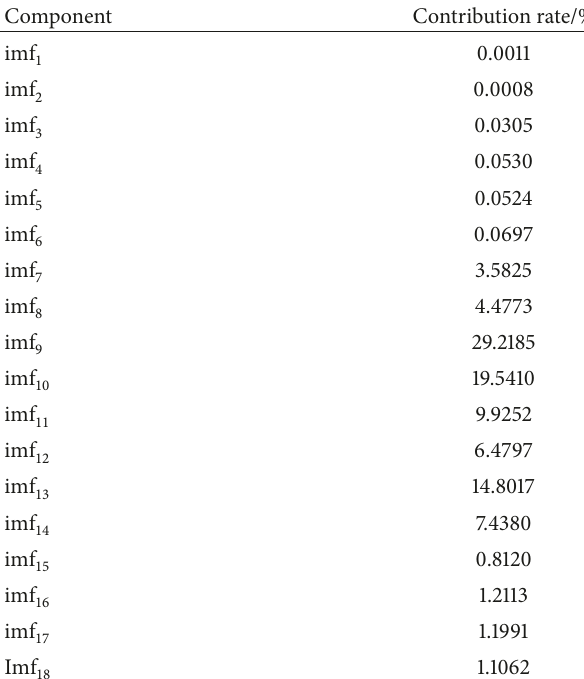
Table 2: IMF components’ variance contribution rates of vibration velocity signal at inner surface.